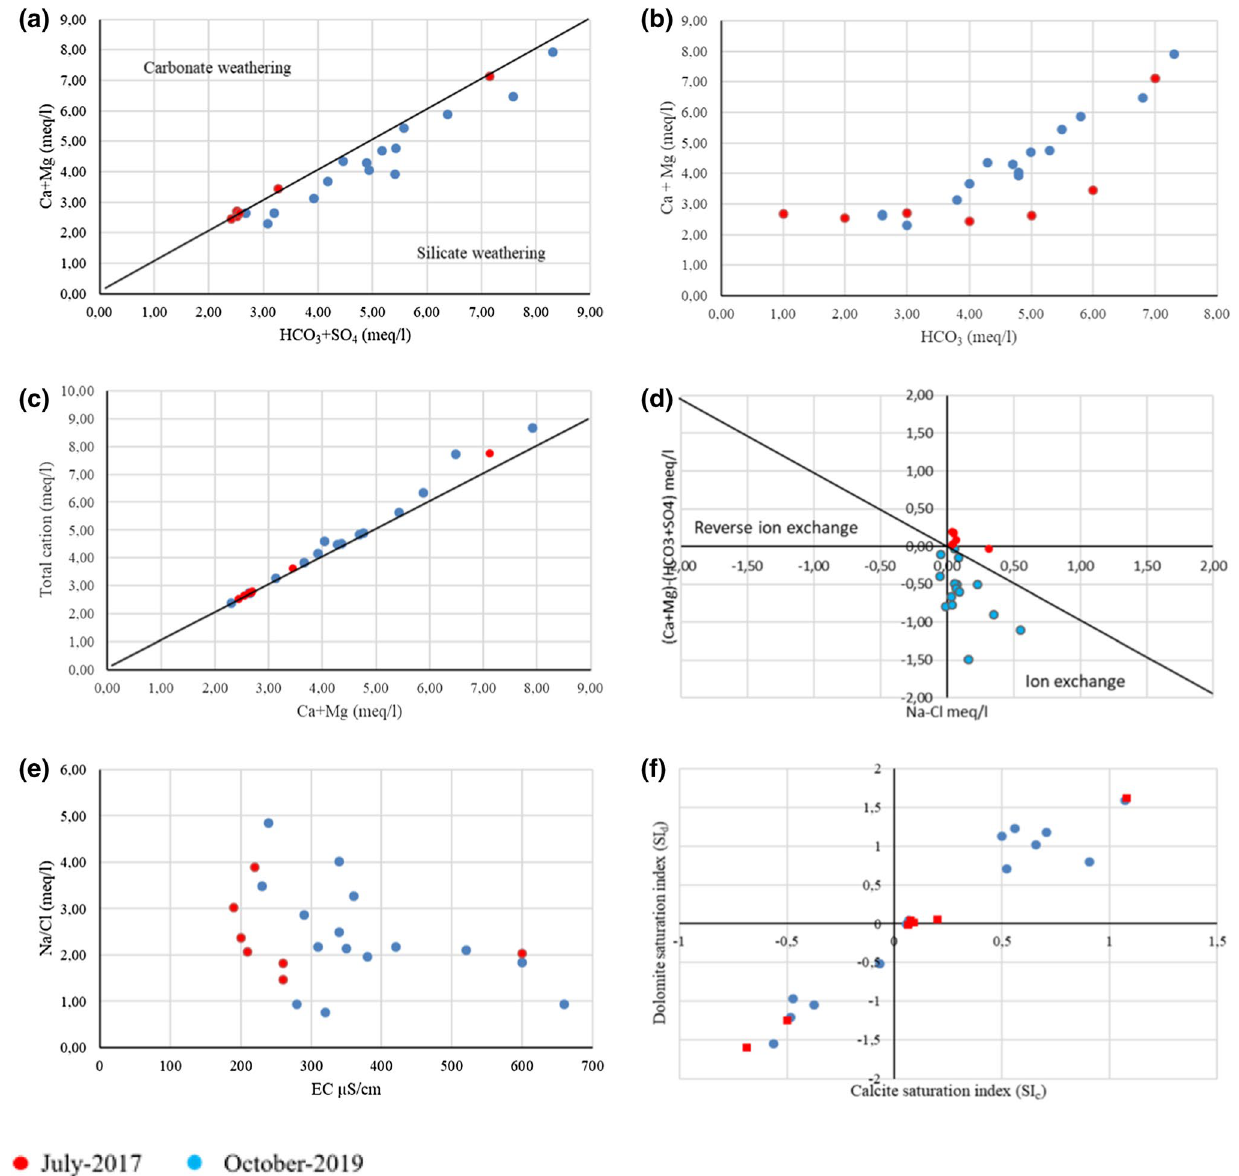
Fig. 6 Graphs of different parameters a scatter plot (Ca 2+ + Mg 2+ )— (HCO 3− + SO 42− ); b the scatter plot (Ca 2+ + Mg 2+ )—(HCO 3− ); c the scatter plot (Ca 2+ + Mg 2+ )—TC; d The scatter plot of